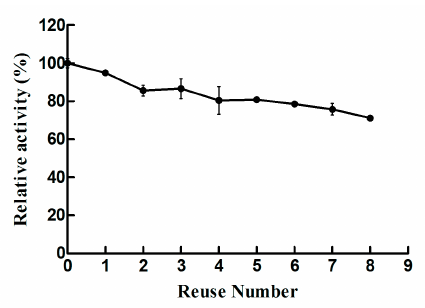
Figure 4. Reusability of Lys-CS-NPs. Activity for each cycle was compared with the initial activity.